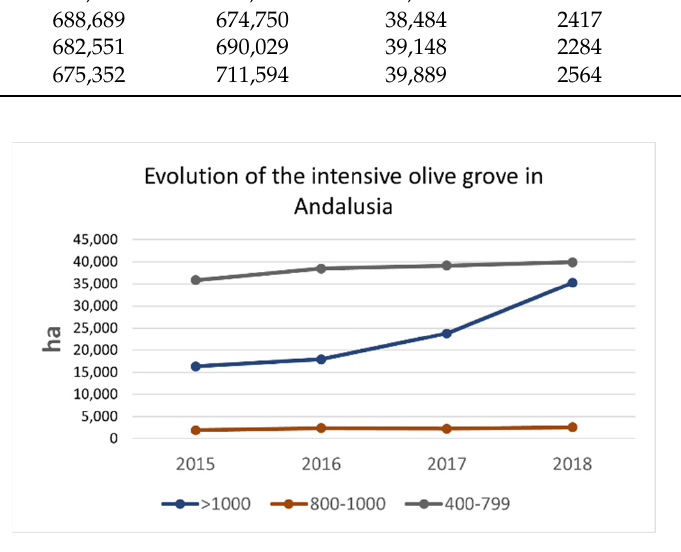
Figure 1. Evolution of the intensive olive grove in Andalusia. Source: Analysis of density in olive plantations in Andalusia. Regional Ministry of Agriculture, Livestock and Fisheries.